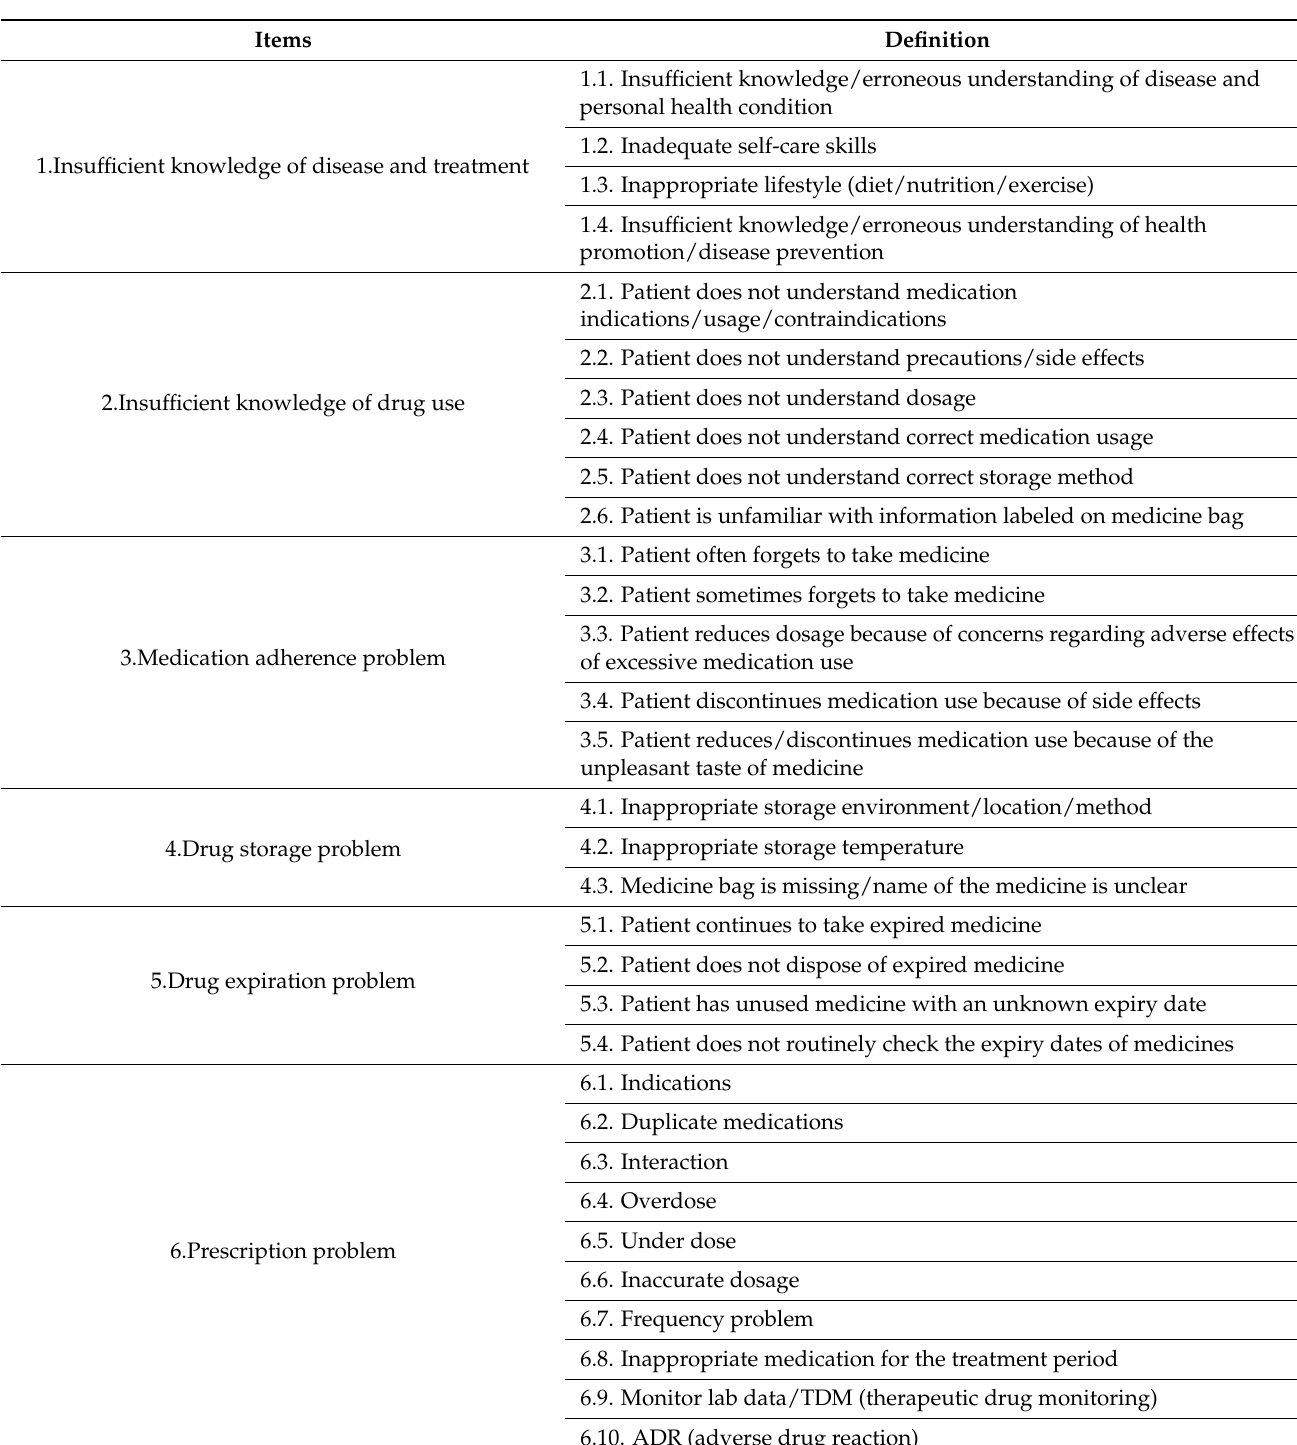
Table 1. Assessment